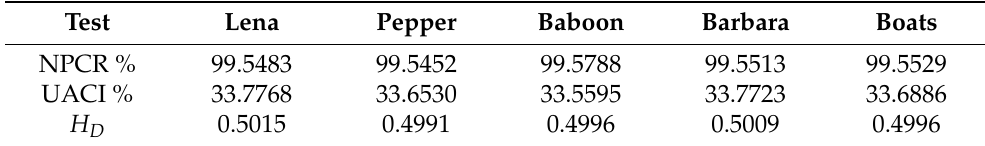
Table 6. Number of pixel change rate (NPCR), unified average changing intensity (UACI), and H D